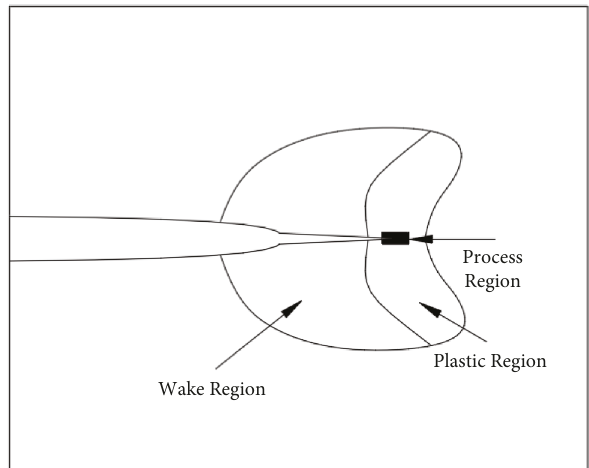
Figure 9: The partition of the crack tip.